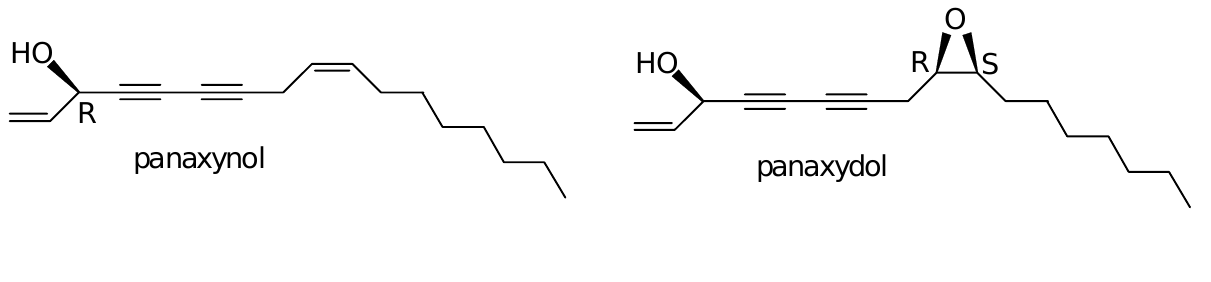
Figure 1. Chemical structures of panaxynol and